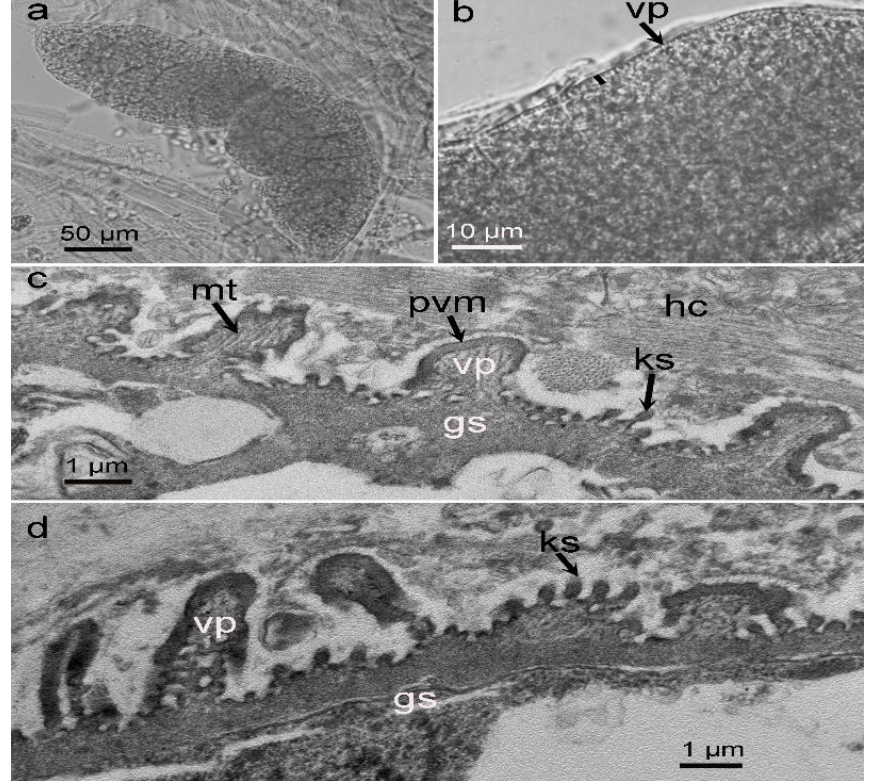
Figure 1. Morphological characteristics of Sarcocystis masoni sarcocysts isolated from the myocardium of an alpaca. ( a ) Overview of a sarcocyst (unstained, light microscopy, LM). ( b ) Sarcocyst bounded by short conical villar protrusions (vp) (unstained, LM). ( c , d ) Diagonal section of a sarcocyst (under transmission electron microscopy, TEM). Sarcocyst surrounded by host cell (hc). The sarcocyst wall exhibits numerous villar protrusions (vp) lined by an electron-dense parasitophorous vacuolar membrane (pvm). Knob-like structures (ks) present on the surface of the pvm. Each vp contains scattered microtubules (mt) in its core, which extend from the tip of the vp into the ground substance (gs).